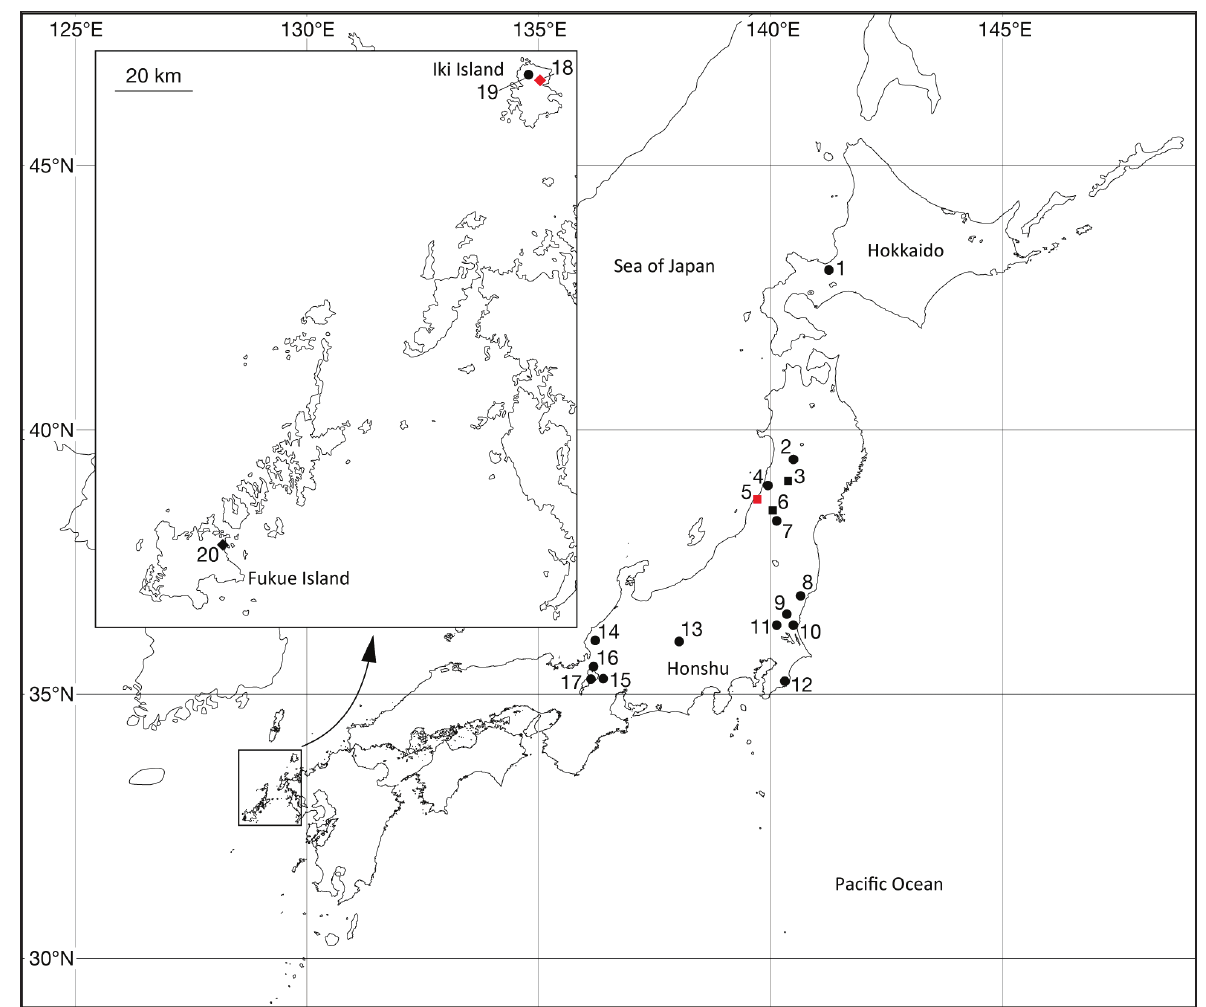
Figure 1. Map showing the collection localities of the specimens examined in this study. The closed squares indicate the localities of J. bousfieldi sp. n. The closed diamonds denote the localities of J. uchiyamaryui sp. n. The closed circles indicate the localities of the referred materials used for the phylogenetic analyses. The symbols in red denote the type locality of each of the new species. Names of localities are shown in Table